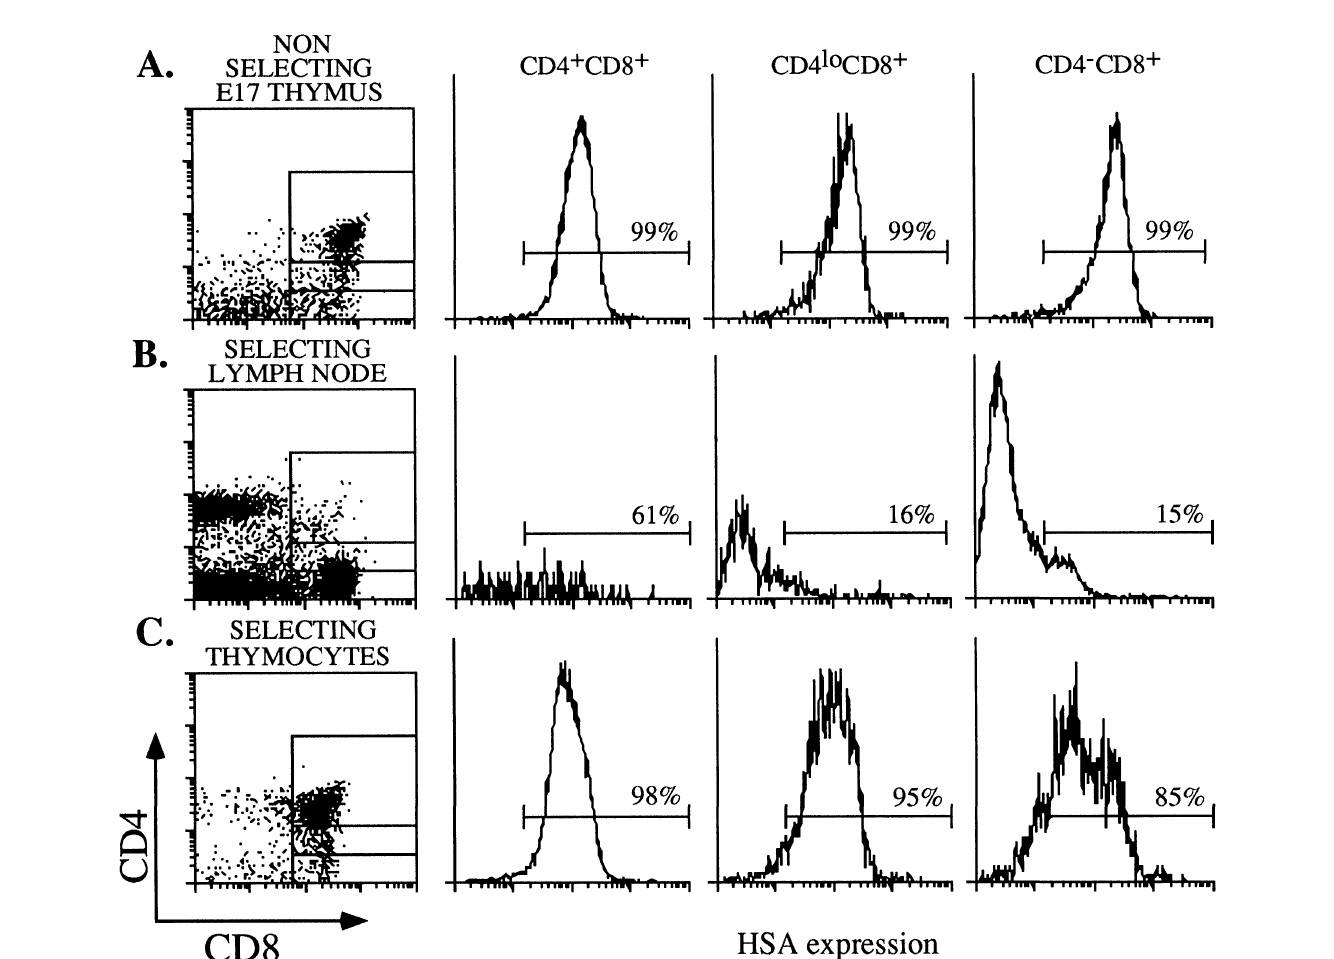
FIGURE 5 CD4-CD8 cells at E17 are immature intermediates. E17 transgenic thymocytes from a nonselecting background (H-2 ) were analyzed for expression of HSA and comparisons made with thymocytes and lymph nodes from a transgenic mouse on a selecting background (H-2b). (A) HSA expression on CD4+CD8 +, CD4CD8 +, and CD4-CD8 subsets shows that thymocytes from a nonselecting background maintain high HSA expression in all subsets. (C) Transgenic thymocytes from a selecting background show high HSA expression on CD4+CD8 cells with downregulation evident on CD4CD8 and CD4-CD8 cells indicating differentiation into mature T cells. (B) More complete downregulation has occurred on the fully mature T cells in the